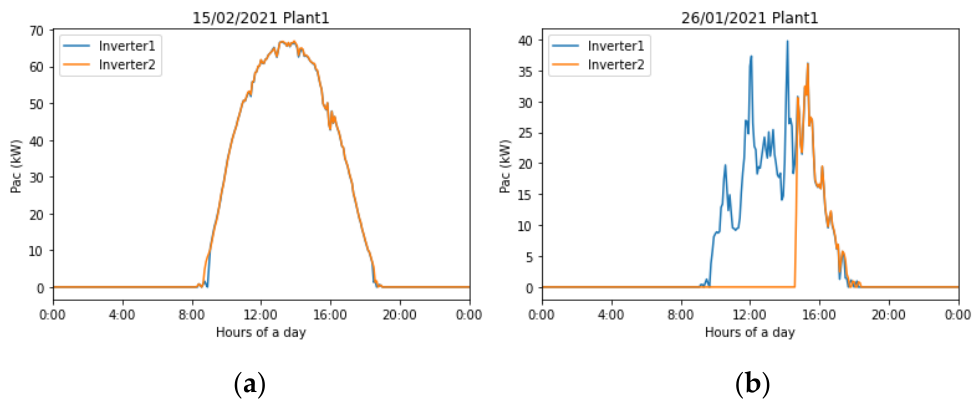
Figure 14. P ac corresponding to inverters 1 and 2 of plant 1 on 15 February 2021 ( a ) and 26 January 2021 ( b ).